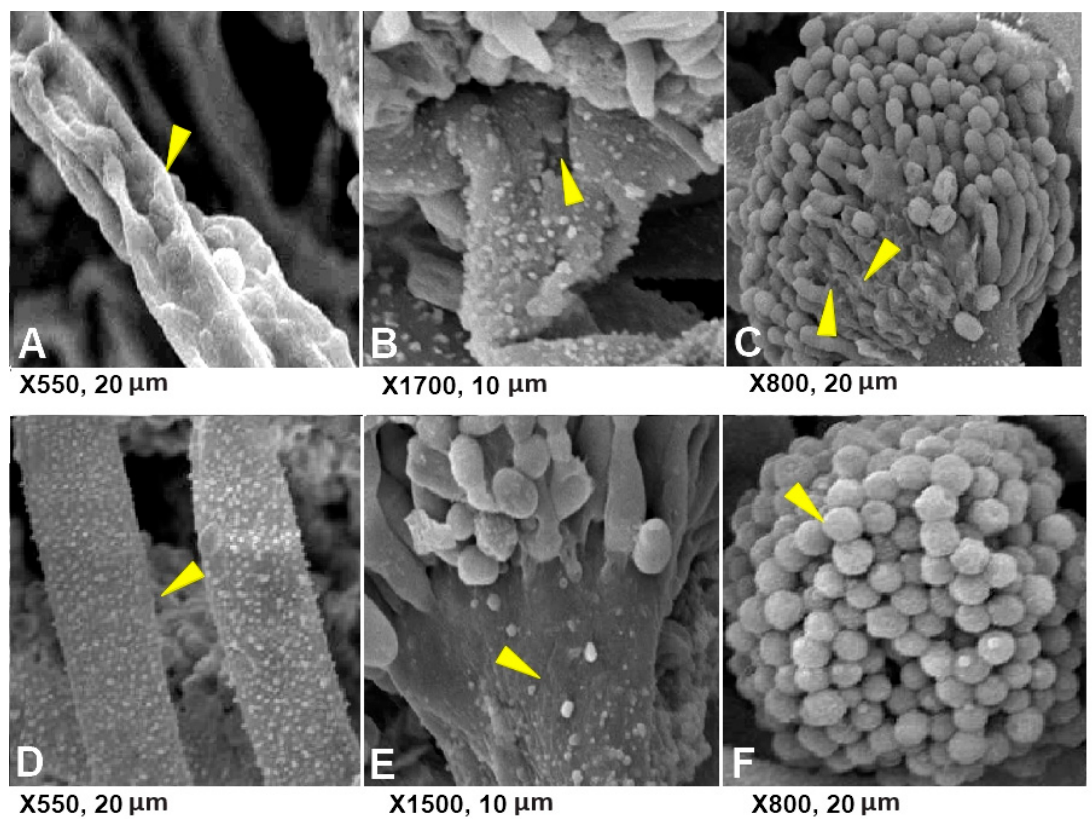
Figure 11. Scanning electron micrographs showing shriveled conidiophores ( A – C ) and the healthy mycelium or conidiophores ( D – F ) of A. flavus on PDA treated with Cu-Chit / NCs hydrogel. The yellow arrows mean hyphae or conidiophore.